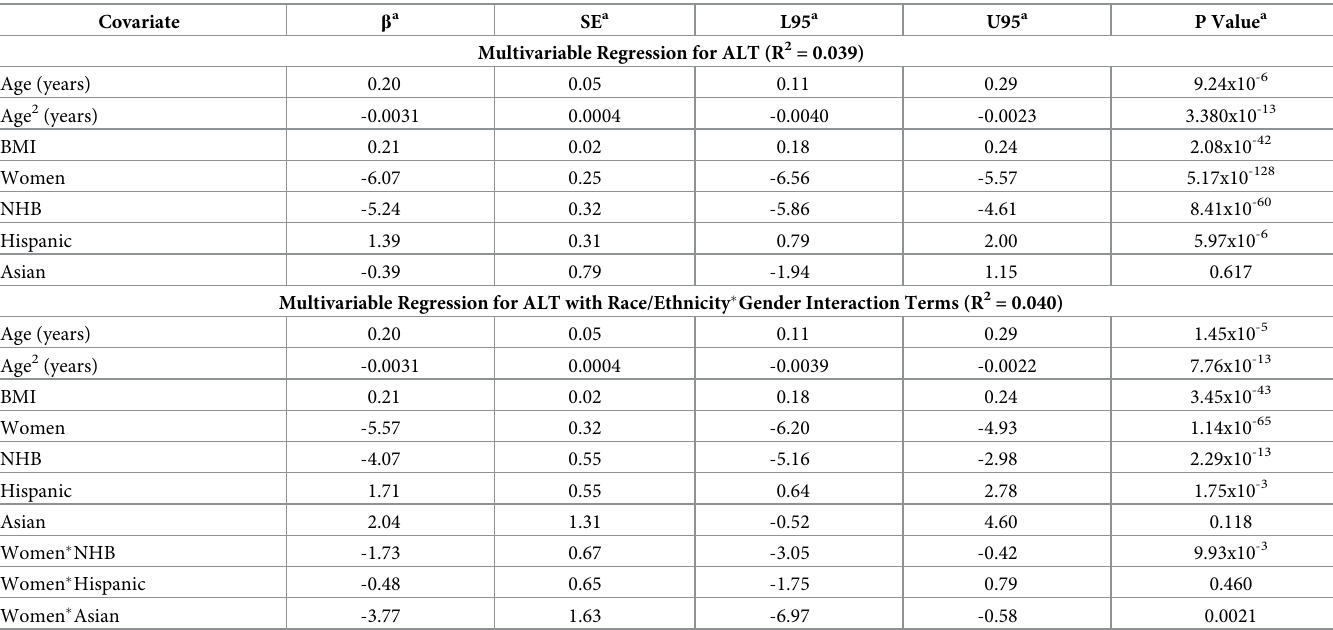
Table 3. Results of multivariable linear regression models for ALT. Covariate β